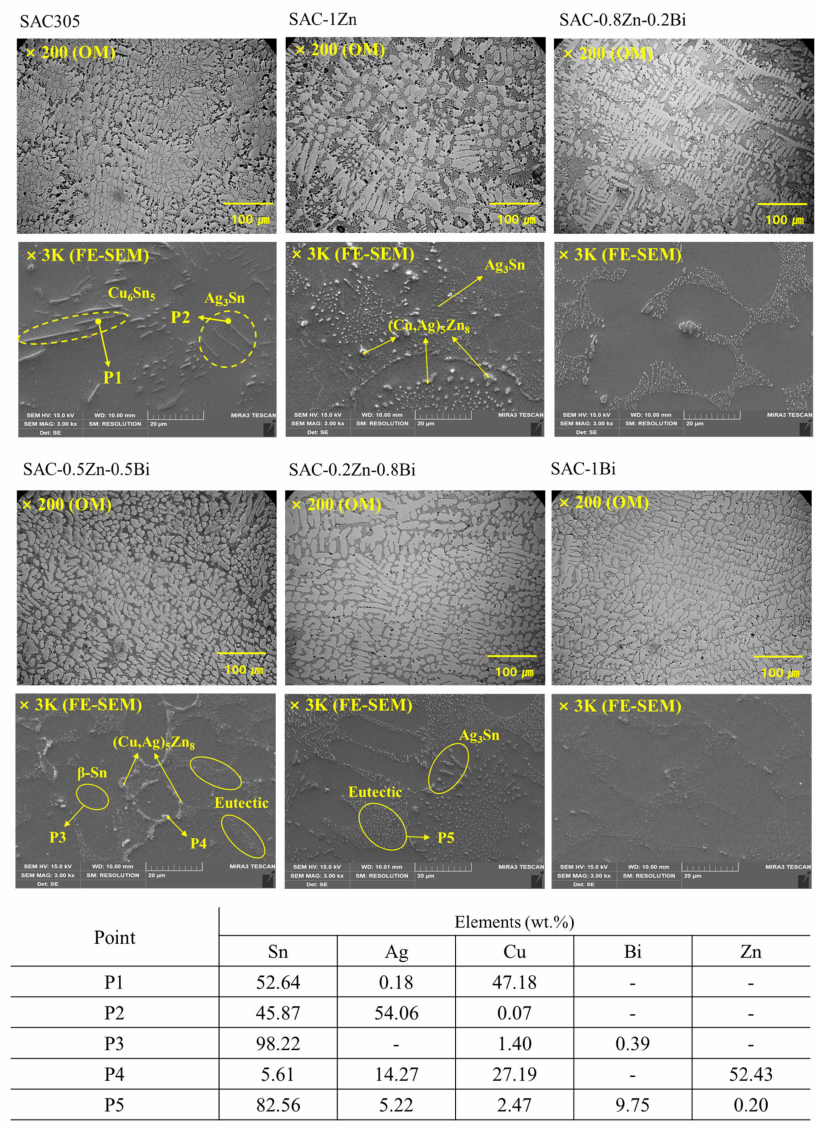
Figure 5. FE-SEM, OM images and EDS results of each alloy under different